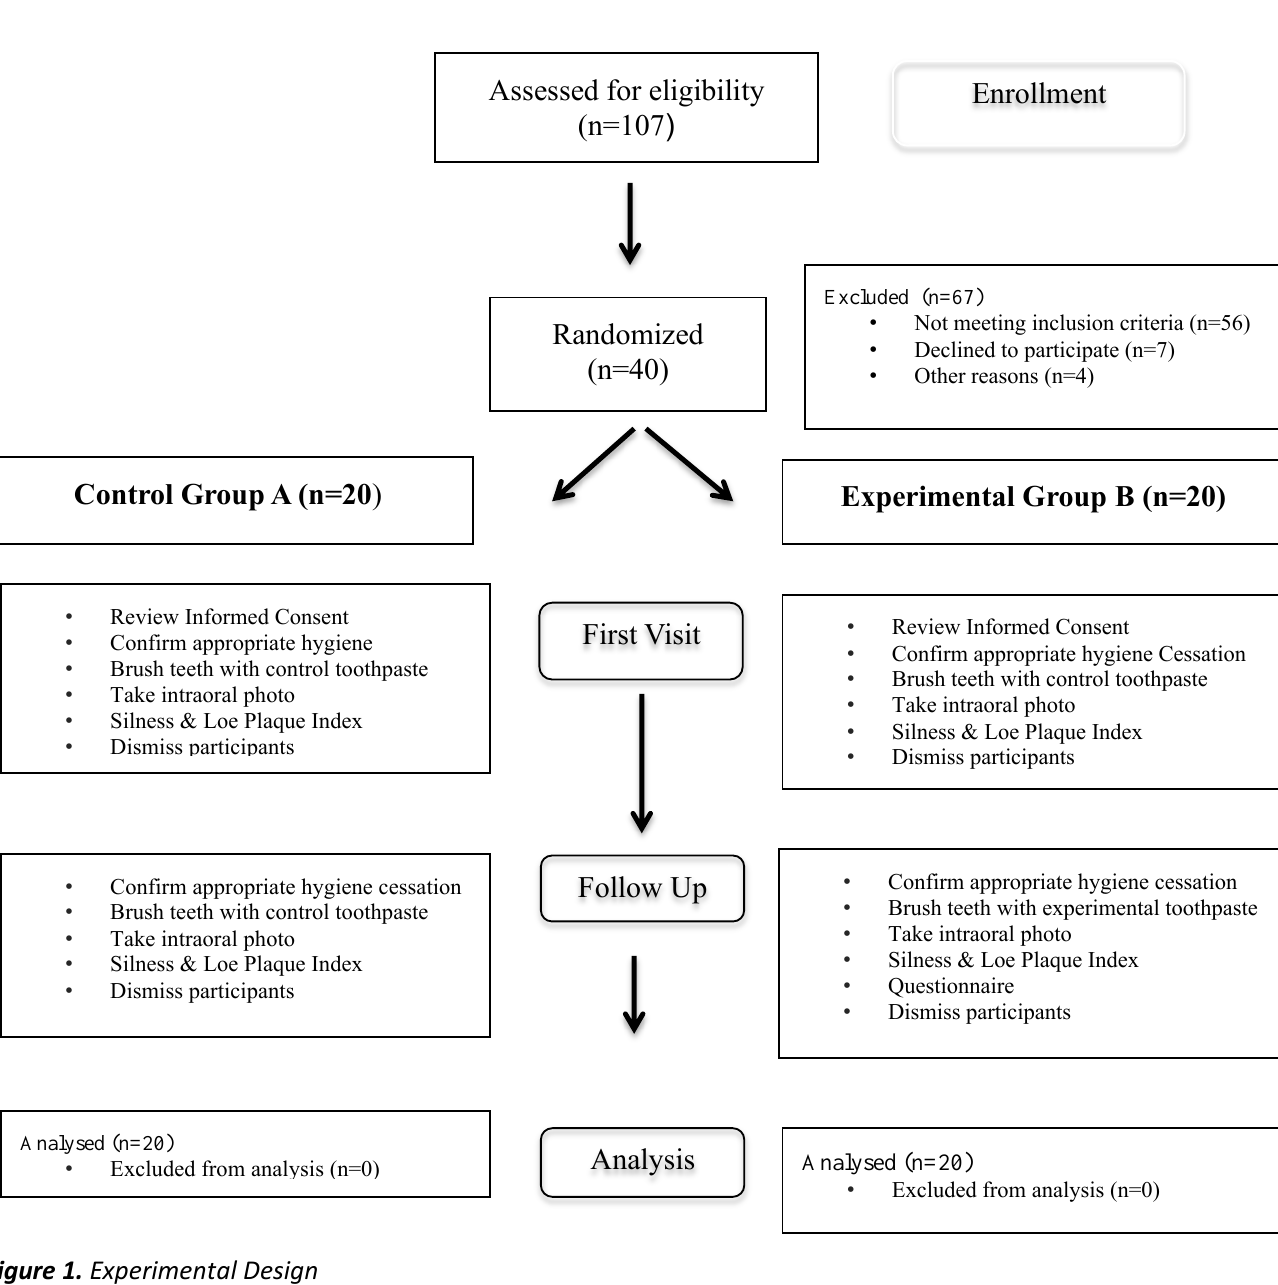
Figure 1. Experimental